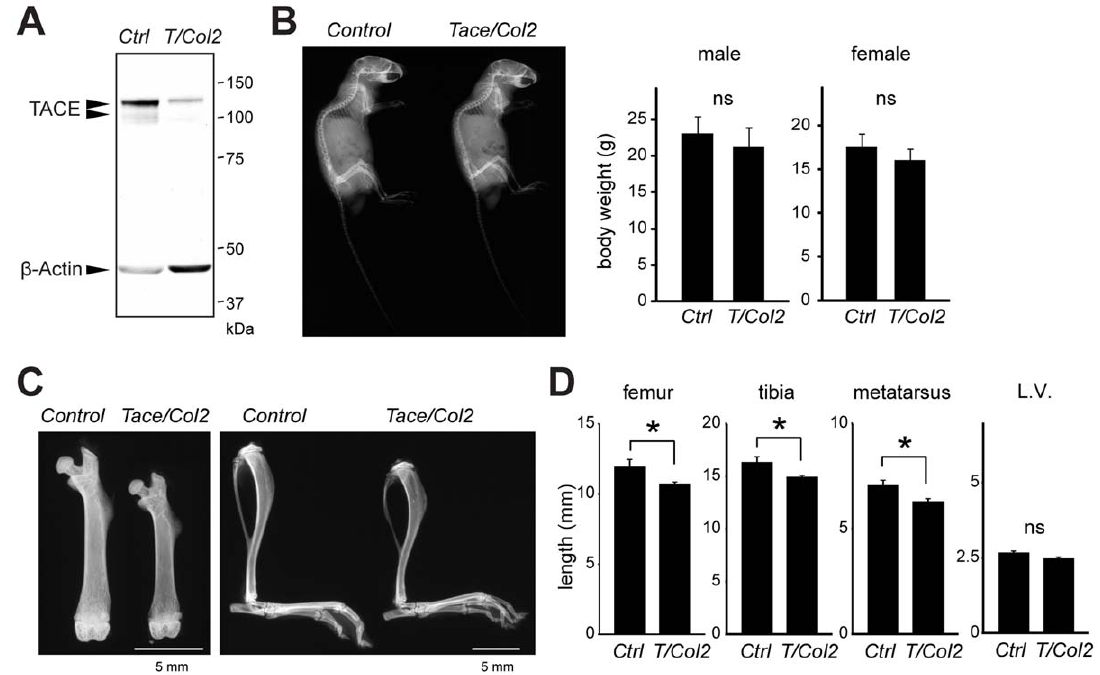
Figure 1. Tace/Col2 mice exhibit shorter long bones. (A) Western blot analysis of TACE and b -Actin in primary chondrocytes harvested from Control ( Ctrl ) or Tace/Col2 ( T/Col2 ) mice. (B) Whole body X-rays reveal no overt abnormalities in the skeletal systems of 8-week-old Tace/Col2 mice compared with the Control animals (left panel). There was no significant difference in the body weights of the 8-week-old Control and Tace/Col2 mice (right panel). (C) X-rays of the lower limbs of 8-week-old Tace/Col2 and Control mice. (D) Comparison of the length of the femur, tibia, third metatarsus, and the sixth lumbar vertebra (L.V.) between 8-week-old Tace/Col2 mice and Control mice (right panel). *, p , 0.05. ns, not significant. The results are expressed as the mean 6 SD of at least three mice in each